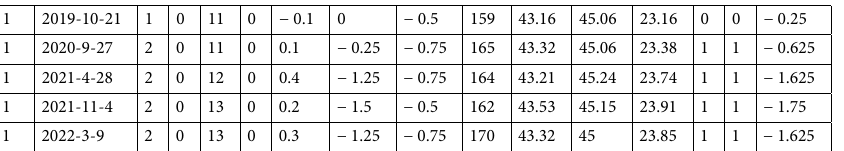
Table 2. The time-series data for an adolescent whose Id is 1. The headers of the table are id, check date, school age groups, gender, age, correction method, uncorrected visual acuity, sphere, astigmatism, axis, corneal curvature K1, corneal curvature K2, axial length, myopia, the level of myopia, SE in that